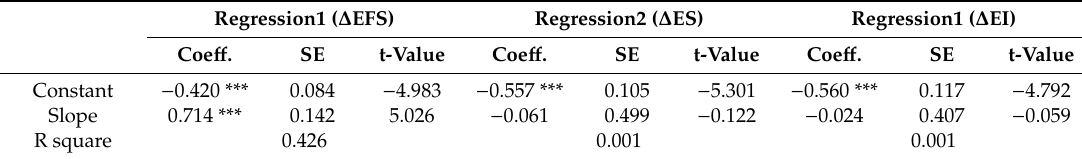
Table 6. The regression results of the supply-side policy e ff ects on the CO 2 fluctuation e ff ect.